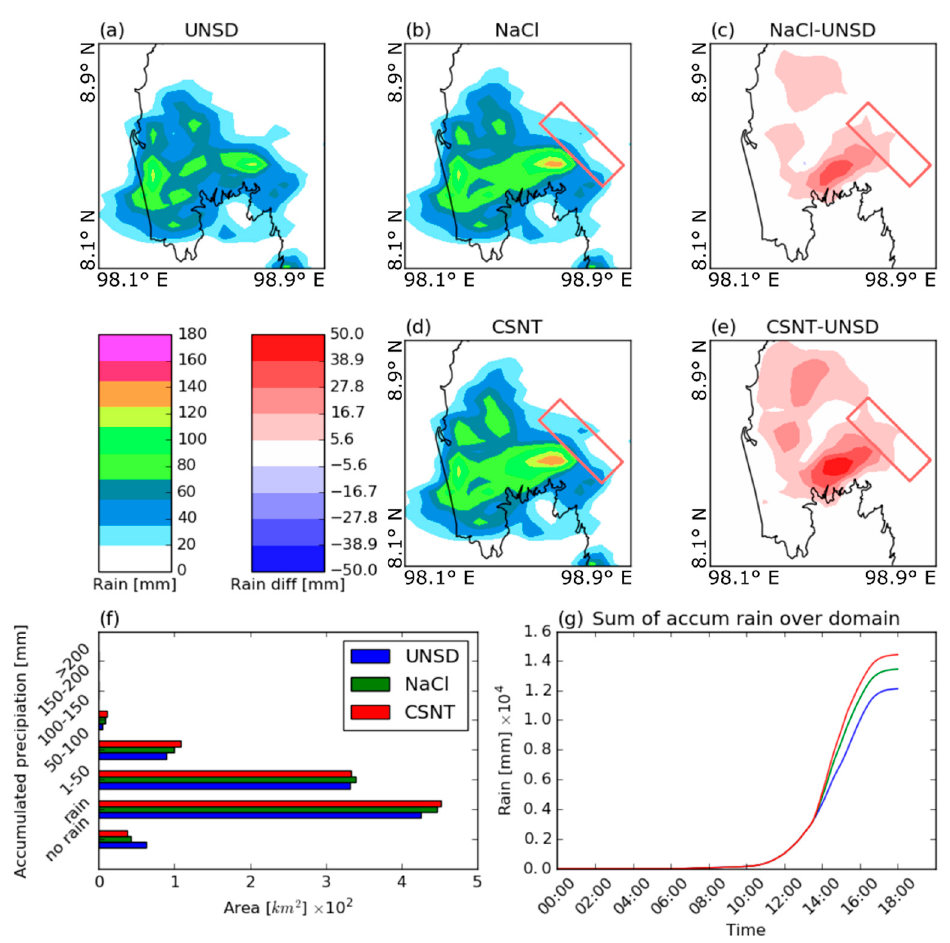
Figure 9. Spatial distribution of accumulated precipitations for the arid case of the Thailand for ( a ) the unseeded case (UNSD), ( b ) core / shell sodium chloride (NaCl) and ( d ) sodium chloride (NaCl) / titanium dioxide (TiO 2 ) nanostructure (CSNT) cases. The red rectangle shows the seeding region. The di ff erences between the accumulated precipitation in the cases shown in panels ( c ) and ( e ). ( f ) Bar plot of areas characterized with di ff erent intensities of accumulated precipitations. ( g ) Time histories of accumulated precipitation in the UNSD (blue), NaCl (green) and CSNT (red) cases.